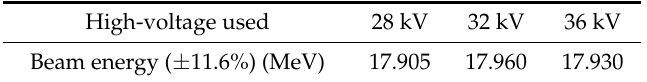
Table 1. Experimentally determined proton beam energy for a fixed exit port and at distinct high voltages for the radio-frequency.